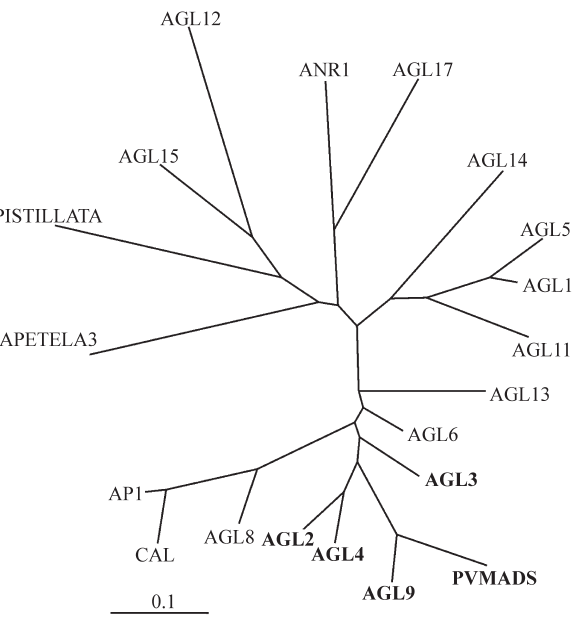
Figure 3 - Alignment of the deduced amino acid sequence of PVMADS with MADS-box amino acid sequences from other plant species. Identical residues indicated by points. NMH7 sequence is related to DEF subfamily of MADS-box gene, however the rest of the sequences are related to the AGL2 MADS-box gene subfamily.